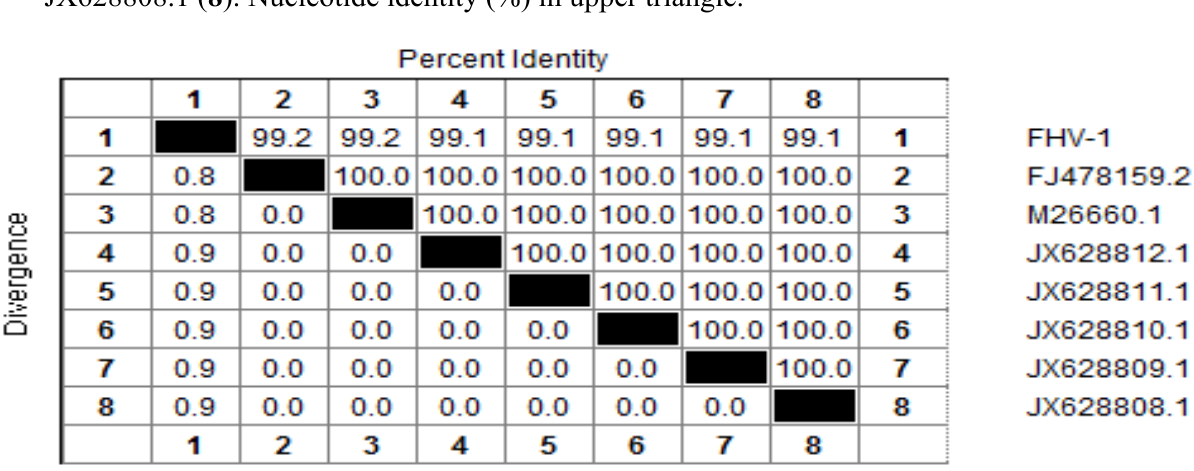
Figure 1. Alignment of the nucleotide sequences of thymidine kinase (TK) gene of Feline herpesvirus type 1 (FHV-1) ( 1 ), with that of reference strains in GenBank: FJ478159.2 ( 2 ); M26660.1 ( 3 ); JX628812.1 ( 4 ); JX628811.1 ( 5 ); JX628810.1 ( 6 ); JX628809.1 ( 7 ); JX628808.1 ( 8 ). Nucleotide identity (%) in upper